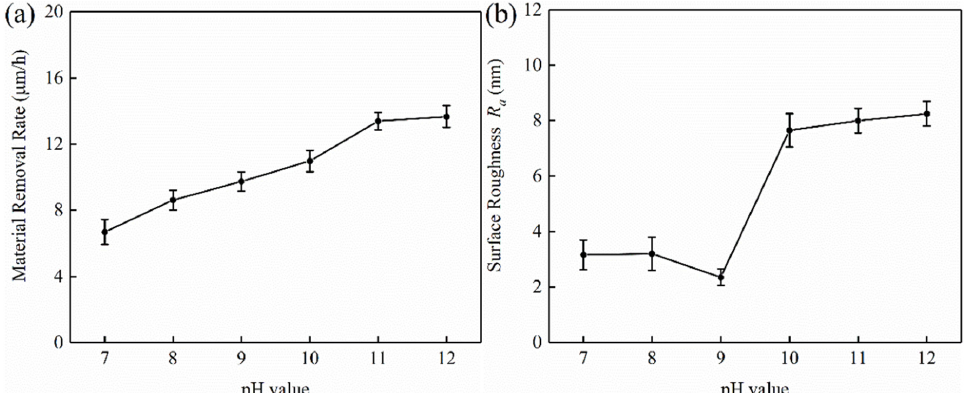
Figure 5. Effect of pH values on the removal rate and surface roughness: ( a ) material remove rate; ( b ) surface roughness.